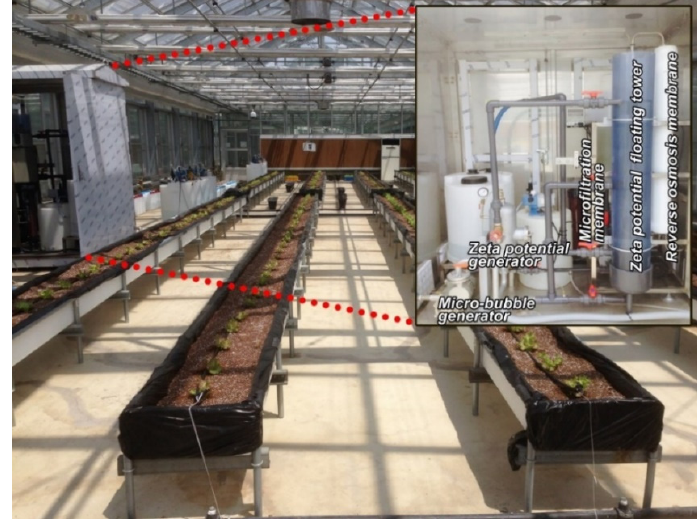
Figure 1. Small-scale brackish water desalination (BWD) system installed in the experimental site and experimental plots planted with lettuce.